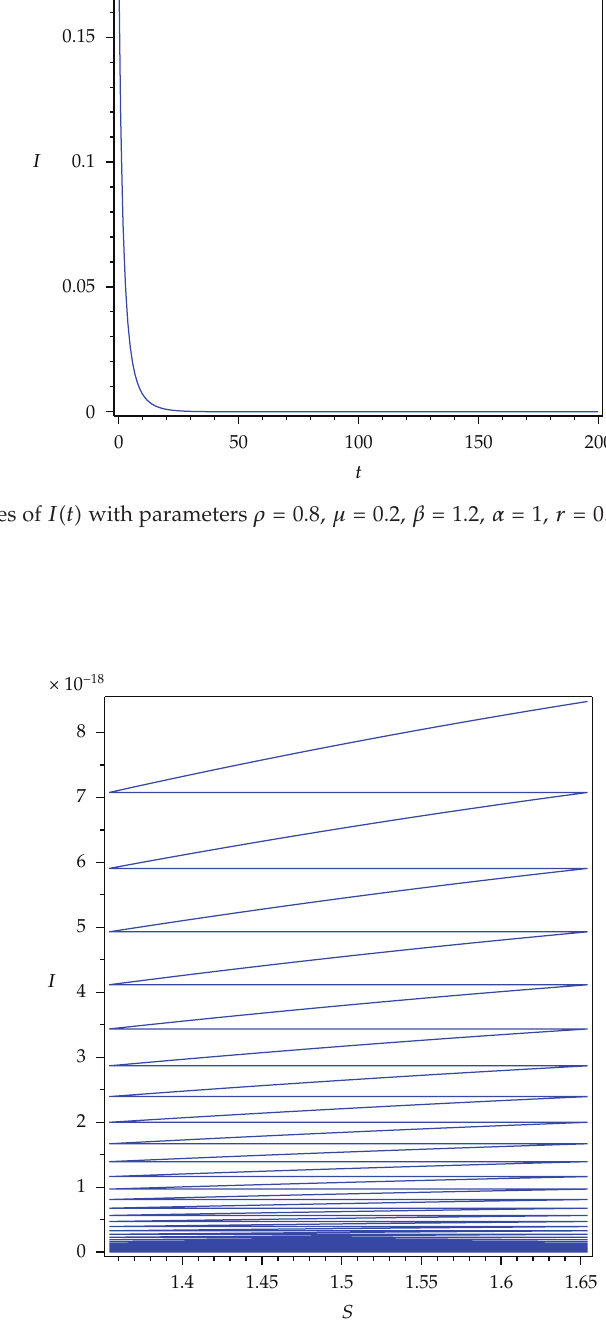
Figure 9: Phase diagram of S (cid:3) t (cid:4) and I (cid:3) t (cid:4) with parameters ρ (cid:7) 0 . 8 , μ (cid:7) 0 . 2 , β (cid:7) 1 . 2 , α (cid:7) 1 , r (cid:7) 0 . 6 , d (cid:7) 0 . 2 , ω (cid:7) 0 . 1 , T (cid:7) 1 , and τ (cid:7)